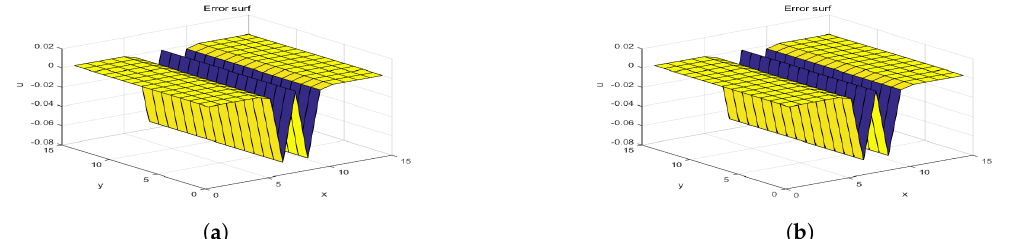
Figure 4. Example 1: ( a ) The error between (a) and (b) in Figure 2, and ( b ) the error between (a) and (b) in Figure